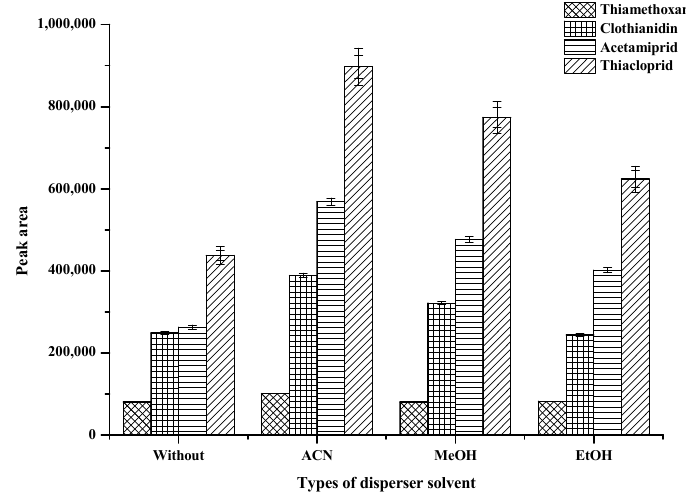
Figure 3. Effect of types of disperser solvent. Conditions: 100 µL of 0.1-mol L − 1 SDS; vortex time 60 s; 100 µL of hydrophobic DES (mole ratio 3:1); centrifugation time at 5000 rpm for 10 min (sample volume 10 mL, 0.5 µg mL − 1 of each neonicotinoid insecticide).